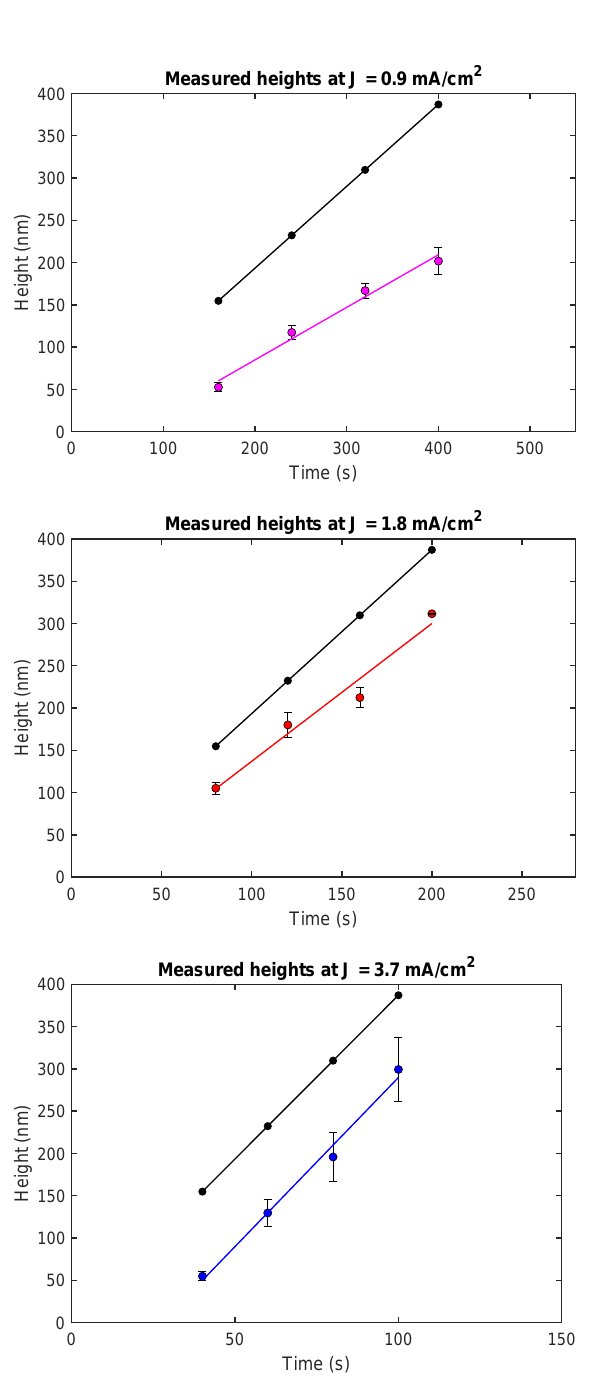
Figure 2. Current density plots, with the theoretically calculated height marked as the topmost black curve in each plot. Experimental values are shown in coloured dots, together with the linear trend between the samples in each series. Each point along the lines consist of an aggregate of average values of several measurements on the same sample in every series. 2 σ error bars are